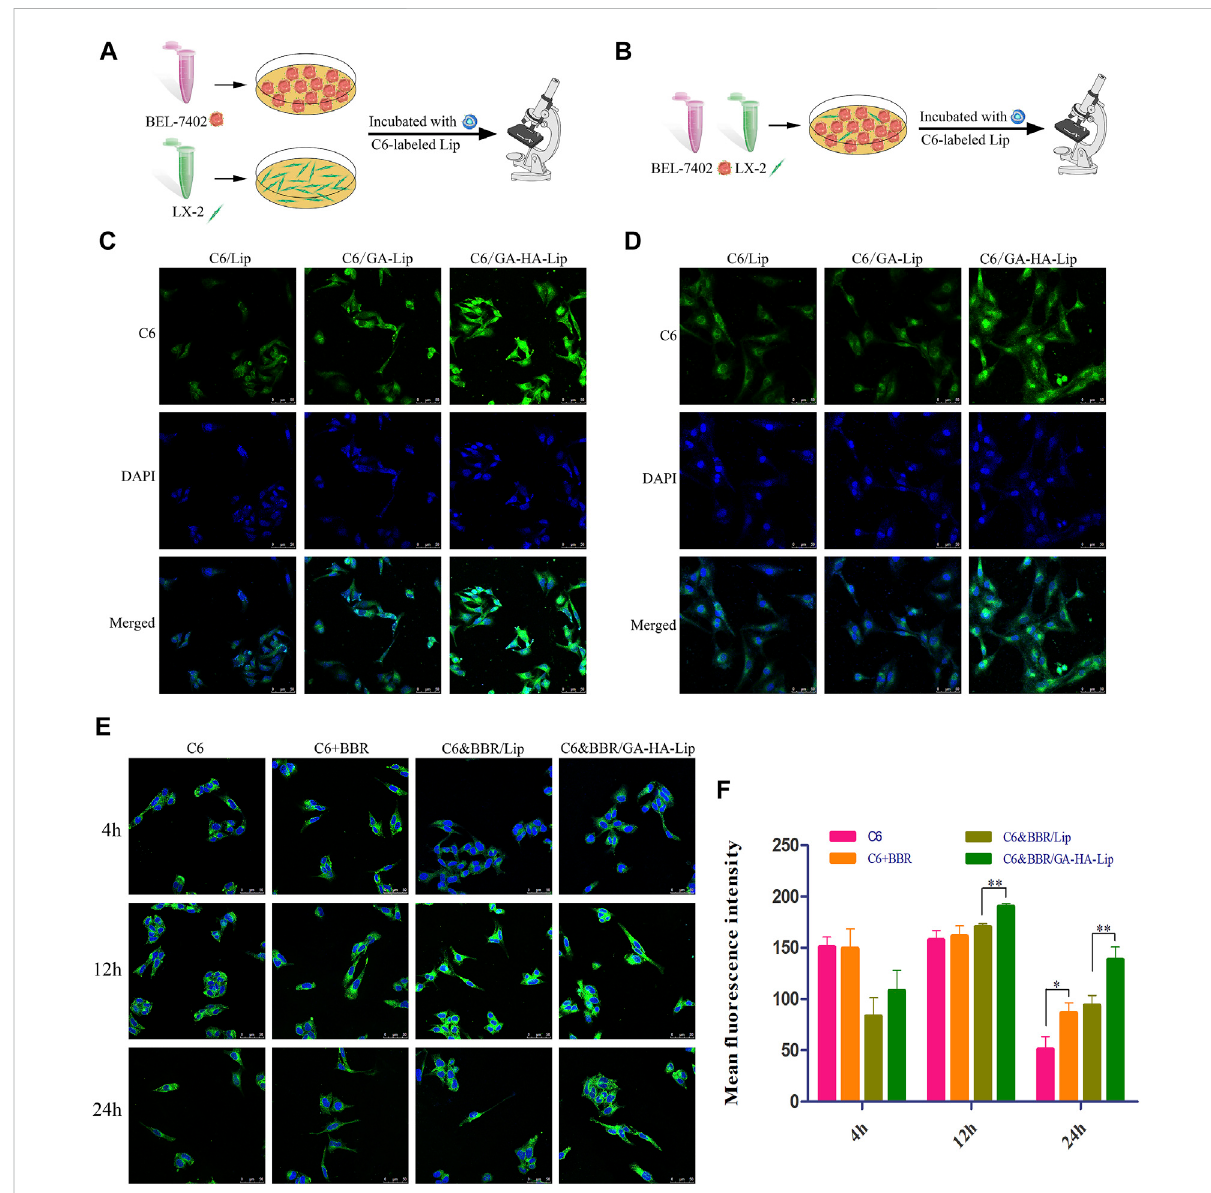
FIGURE 3 Invitro cellularuptakeanddrugdetentionstudiesinaco-culturedsystem. (A) CelluptakemodelofBEL-7402andLX-2cells. (B) Drugretention assaymodel.CLSMimagesofBEL-7402cells (C) andLX-2cells (D) treatedwithC6/Lip,C6/GA-Lip,andC6/GA-HA-Lipat2 h,wherethenucleiwere labeled with DAPI (blue) and Lip were labeled with C6 (green); scale bars represent 50 μ m. (E) Confocal microscopy and (F) quantitative analysis